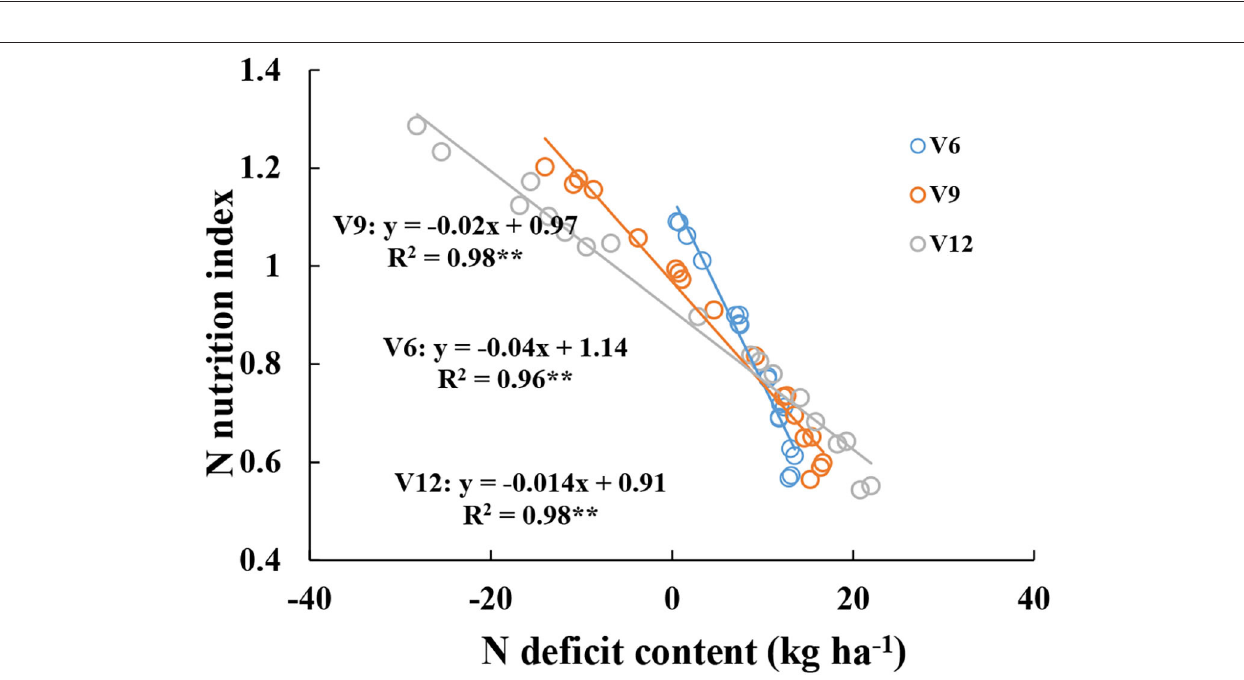
were similar to the FIPAR values of the bottom leaf layer, and the FIPAR values of the upper leaf layer were significantly lower than FIPAR values of the middle and bottom leaf layers. The increased proportion of the average FIPAR values of the middle and bottom leaf layers was 18 and 10% at N0 and N225 treatments, respectively. The bottom FIPAR values of the higher N treatments were lower than the bottom FIPAR values of the lower N treatments.